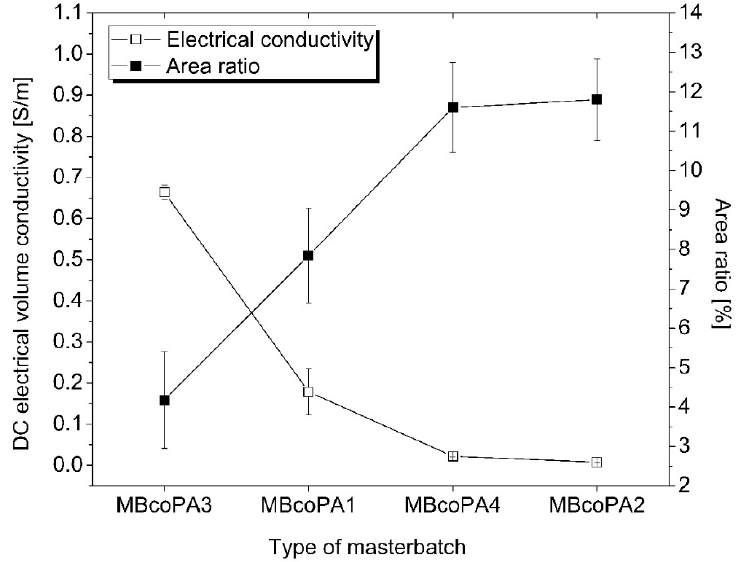
Figure 3. Dependence between the volume electrical conductivity and A A for the studied masterbatches.